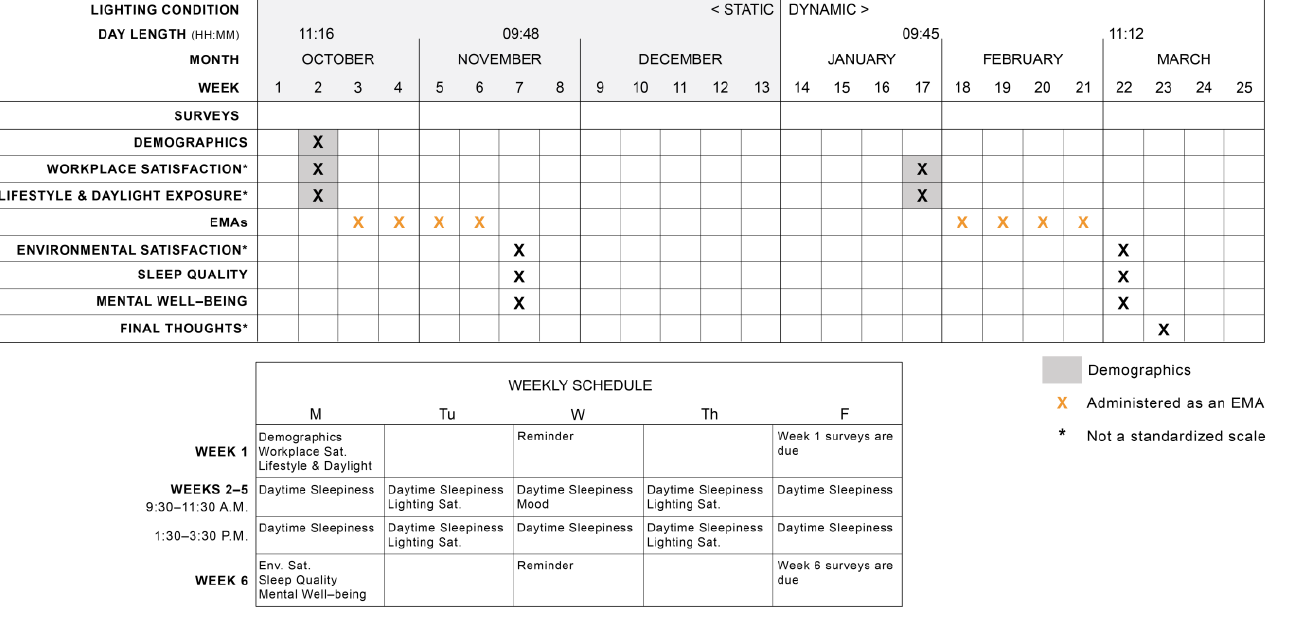
Figure 5. Overview of Survey Administration Schedule.